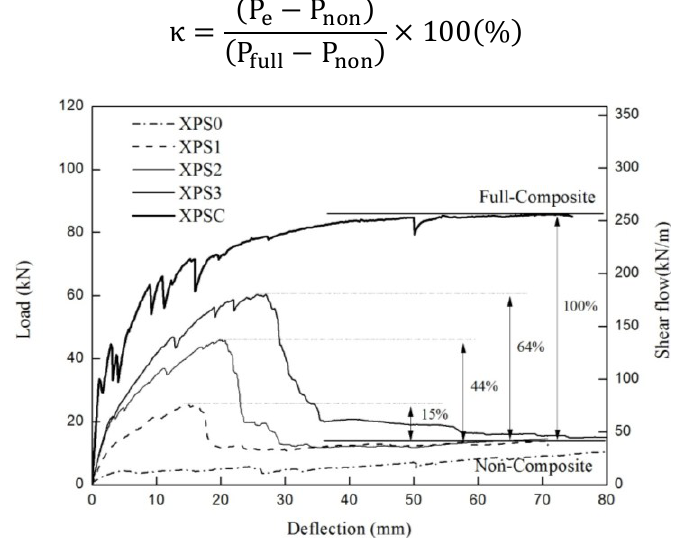
Figure 5. Load-deflection curve of the specimen using extruded polystyrene (XPS)